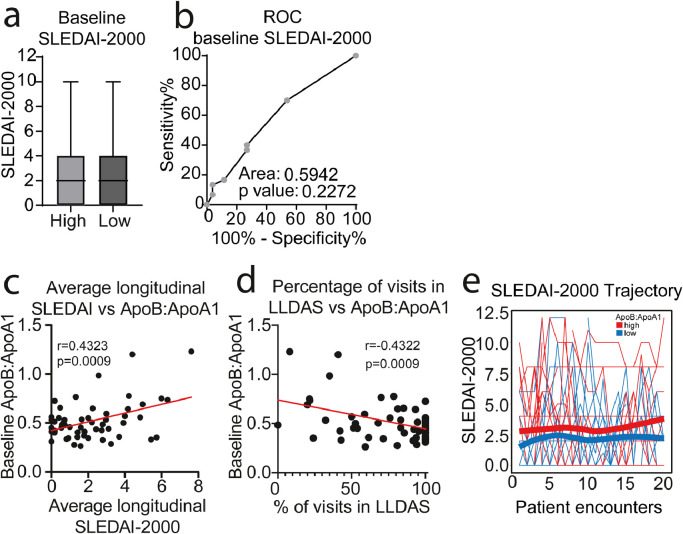
Longitudinal analysis of disease activity differs between high and low ApoB:ApoA1 ratio groups. (a) Systemic Lupus Erythematosus Disease Activity index (SLEDAI-2000) comparison between high (n=30, red) and low (n=26, blue) ApoB:ApoA1 ratio JSLE patients. Box and Whisker plot showing mean and 1st/3rd quartiles and minimum/maximum values, T test. (b) ROC curve analysis of baseline SLEDAI-2000 score of patients in Group-1/1A (n=30) compared to patients in Group-2/2A (n=26). Area under the curve (AUC) displayed. (c) Pearson's correlation between baseline ApoB:ApoA1 ratio and average SLEDAI-2000 of JSLE patients (n=56) measured over 3-7 years of follow up (mean years of follow-up per patient=4.9, mean number of visits per patient=17.1). (d) Pearson's correlation between baseline ApoB:ApoA1 ratio and longitudinal Lupus Low Disease Activity State (LLDAS) (n=56). (e) Longitudinal assessment of JSLE patient (n=56) SLEDAI-2000 score trajectories over 20 clinical encounters displayed as spaghetti plots. Each line represents one JSLE patient. Red=patients with high baseline ApoB:ApoA1; Blue=patients with low baseline ApoB:ApoA1. Smoothing lines were added to indicate the trend of high and low ApoB:ApoA1 groups.